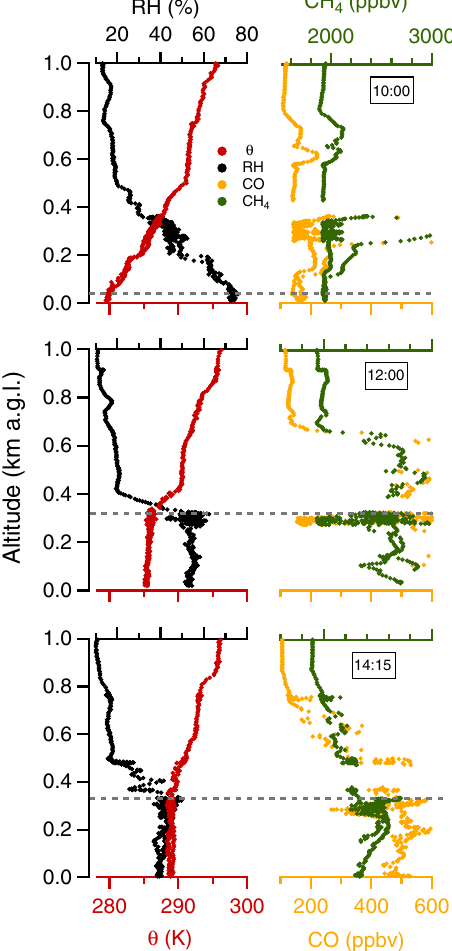
Figure B1. Vertical profiles of potential temperature, θ (K); relative humidity, RH (%); mixing ratios of carbon monoxide, CO (ppbv); and methane, CH 4 (ppbv), measured from the P3-B aircraft over Fresno on 18 January 2013. The horizontal dashed gray line indi- cates the mixed boundary layer